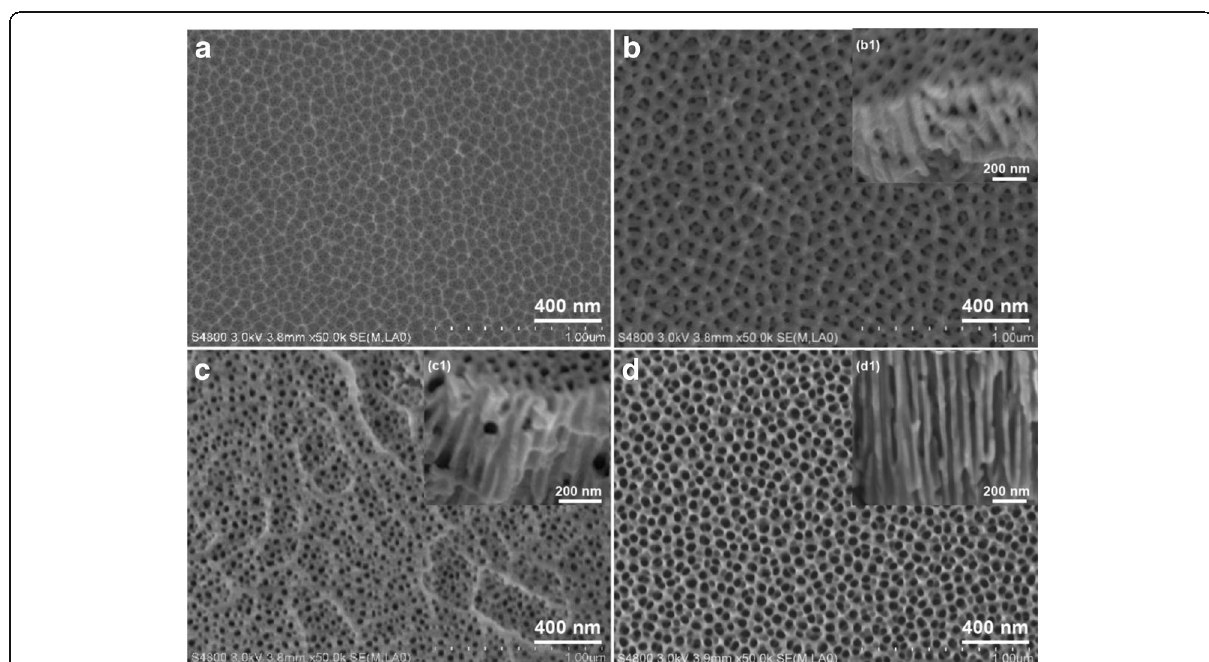
Fig. 4 SEM images of the porous anodic alumina (PAA) with different times of second anodization duration a 0 min, b 40 min, c 60 min, and d 80